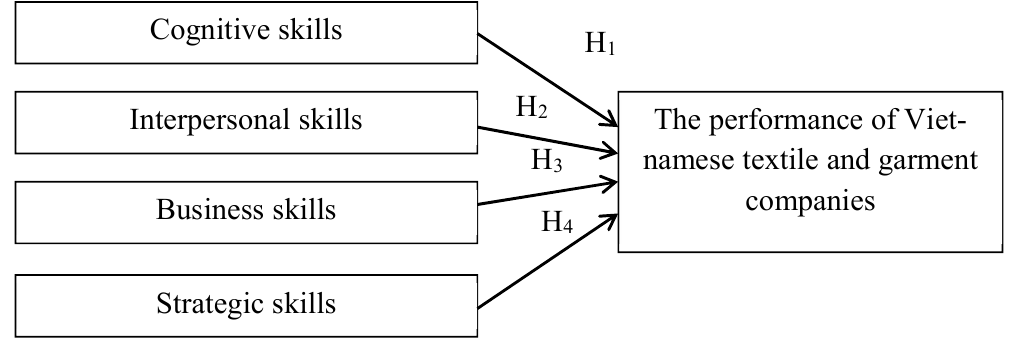
Fig. 1. The effects of leadership skills on the performance of Vietnamese textile and garment